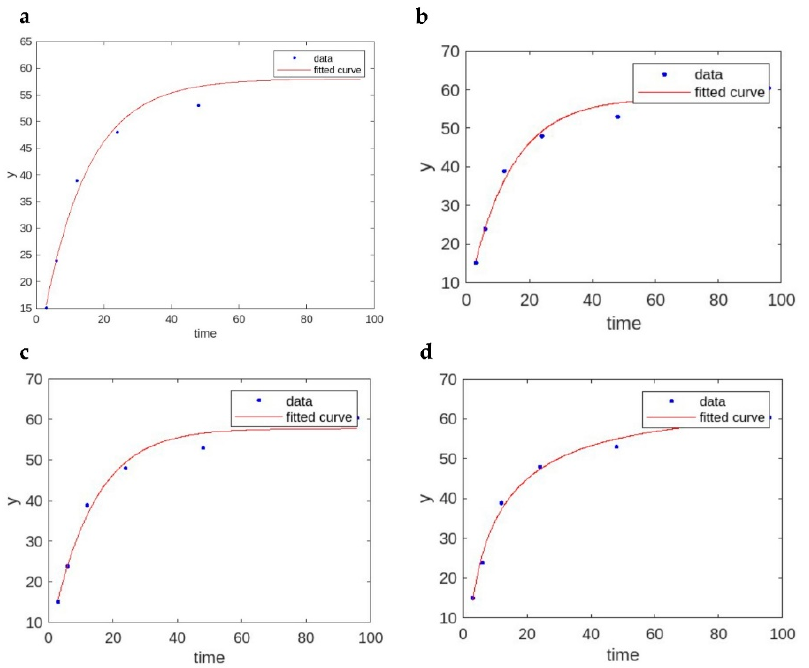
Figure 4. Ruminal fermentation curve for vetch forages. ( a ) Model I, ( b ) Model II, ( c ) Model III, and ( d ) Model IV; X = incubation time, Y = fermentation amount.